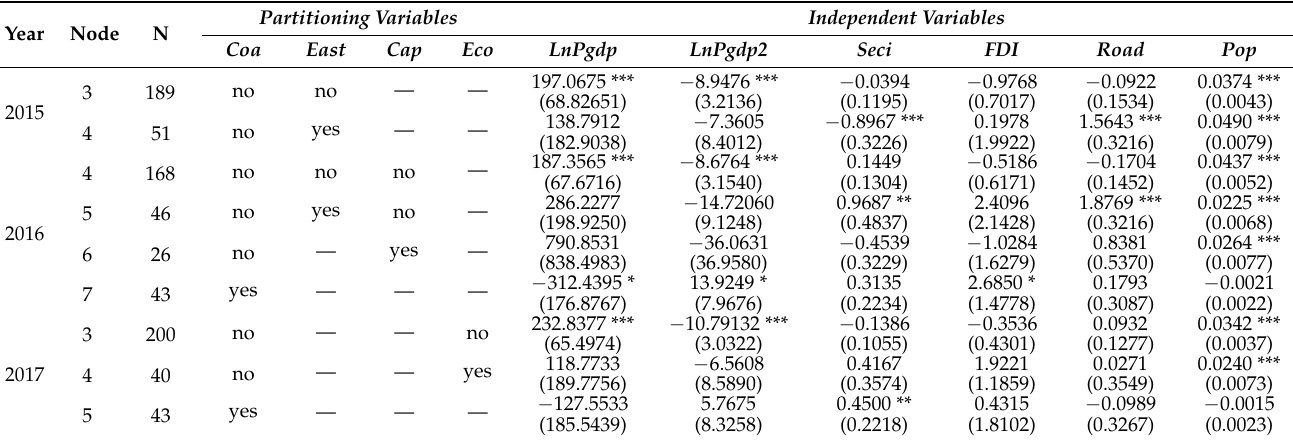
Table A5. Results of the recursive analysis of air pollution influences under the distance spatial weight matrix (SWM) (distance = 1000 km) for the period